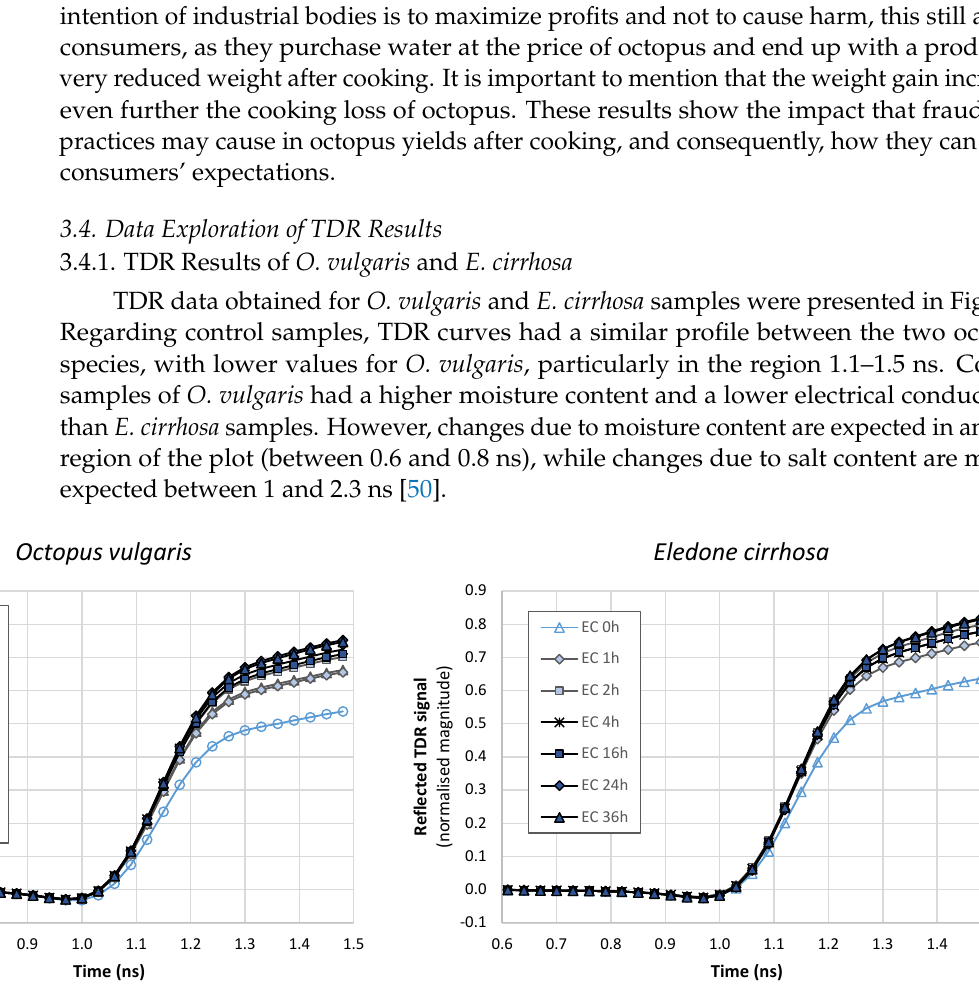
Figure 4. Time domain reflectometry (TDR) data of Octopus vulgaris (OV) and Eledone cirrhosa (EC) samples immersed in freshwater for different periods of time (0.5 h to 36 h). Data represent the average of all samples from different trials.